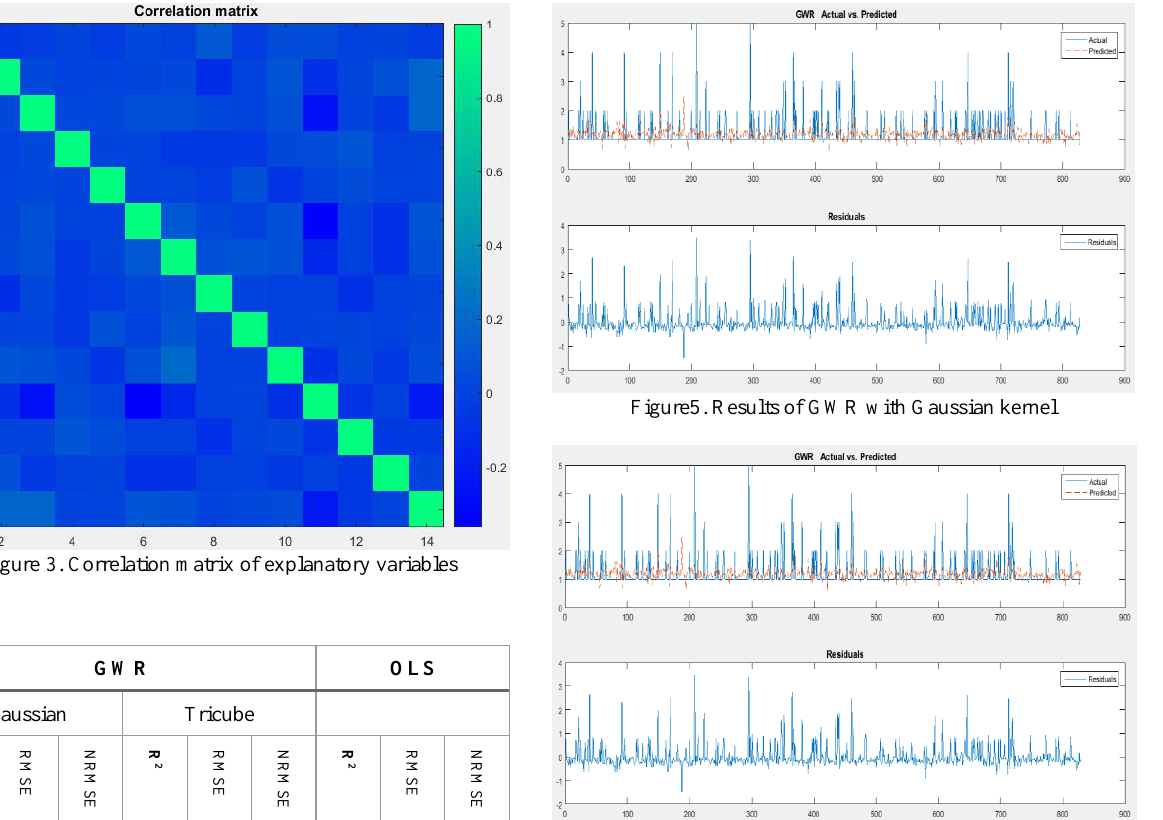
Figure 6. Results of GWR with Tricube